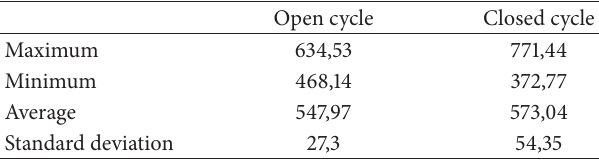
Table 3: Parameters of the Monte Carlo